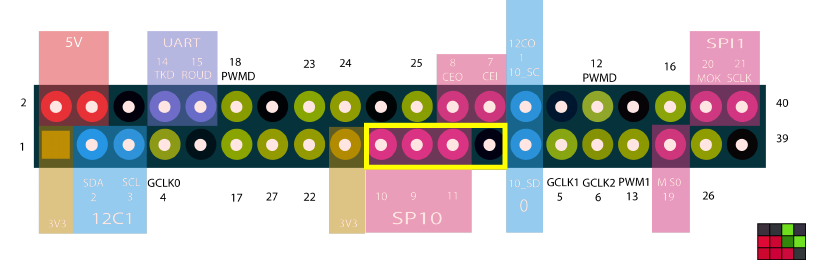
Figure 10. Raspberry Pi utilized GPIO pins.